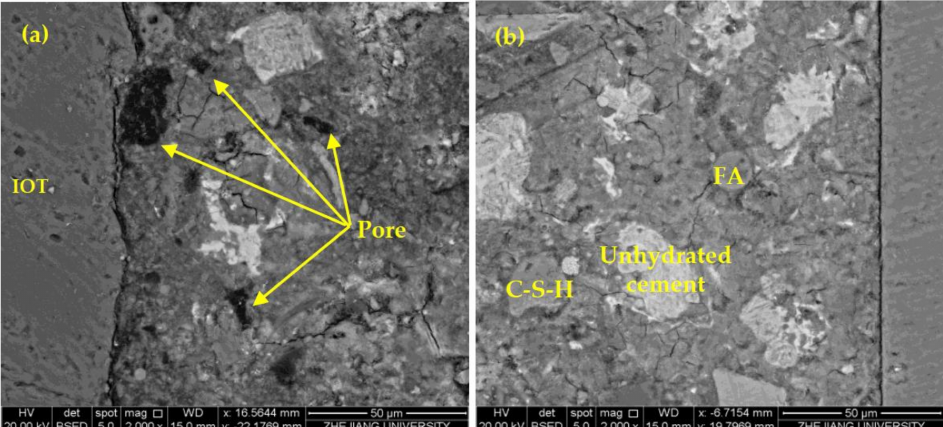
Figure 9. The interface transition zone (ITZ) of HPMC1 ( a ) and HPMC0 ( b ) at 28